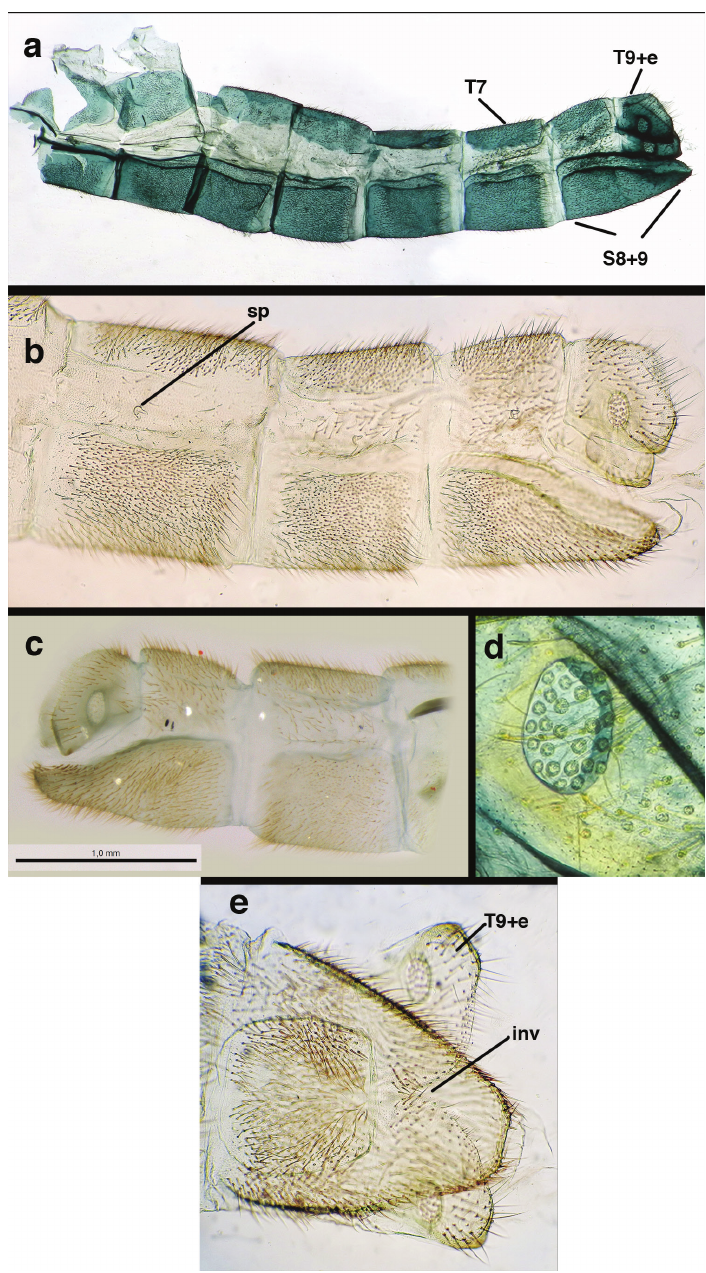
Figure 19. Ungla bolivari -like species: Male abdomen, ( a ) segments A3-terminus, lateral ( b ) segments A6-terminus, lateral ( c ) segments A7 – terminus, lateral, without coverslip ( d ) callus cerci ( e ) termi- nus, dorsal, with coverslip. inv invaginated dorsal cleft in T9+ectoproct sp spiracle S8+9 fused eighth and ninth sternites T7 seventh tergite T9+e fused ninth tergite and ectoproct (all: Venezuela, Boconó, MIZA; images,